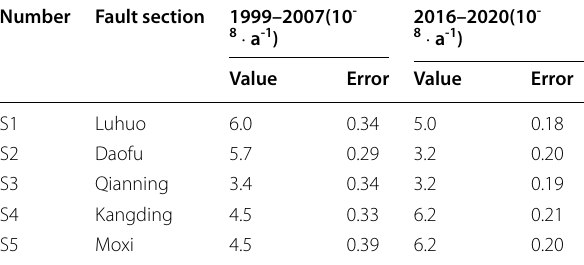
Table 2 Maximum shear strain rates on each segment of the